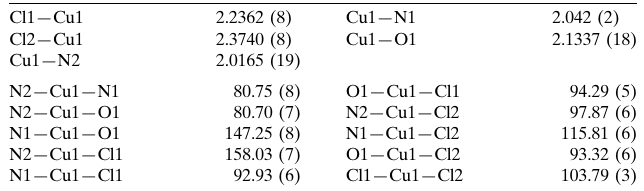
Selected geometric parameters (A˚ , (cid:1)